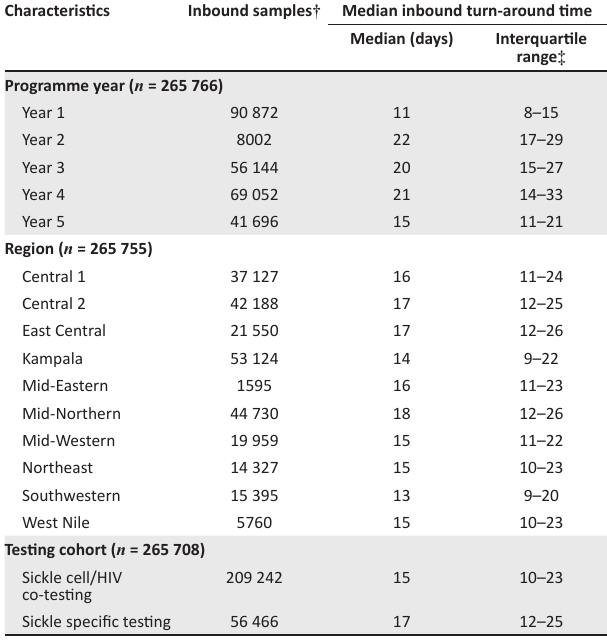
TABLE 1: Characteristics of sickle cell samples tested in Uganda from 01 February 2014 to 31 March 2019.